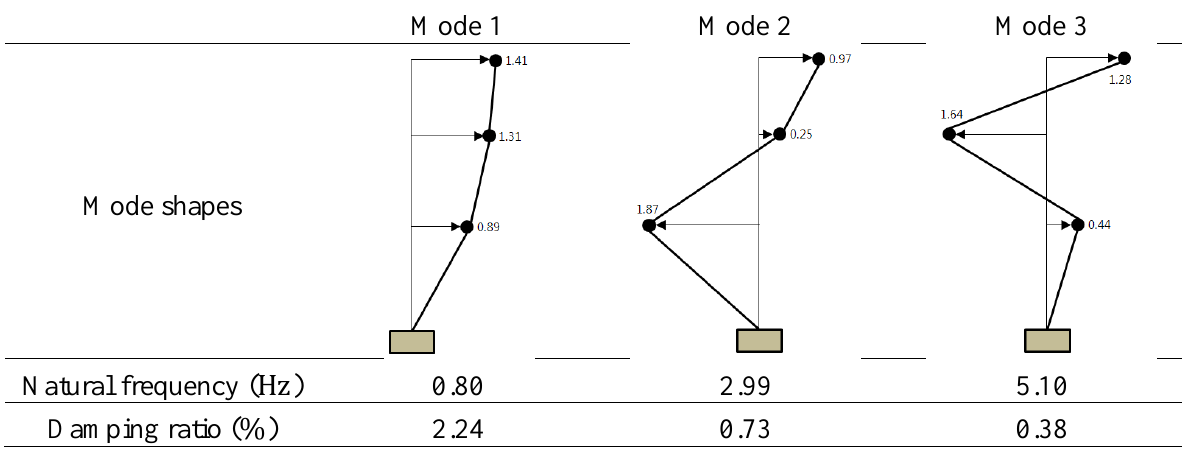
Figure 10. Modal parameters obtained from SSI